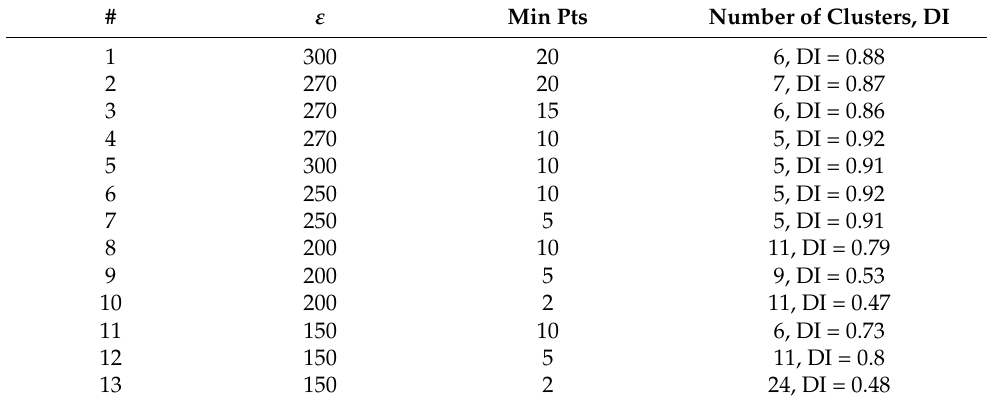
Table 5. DI index for